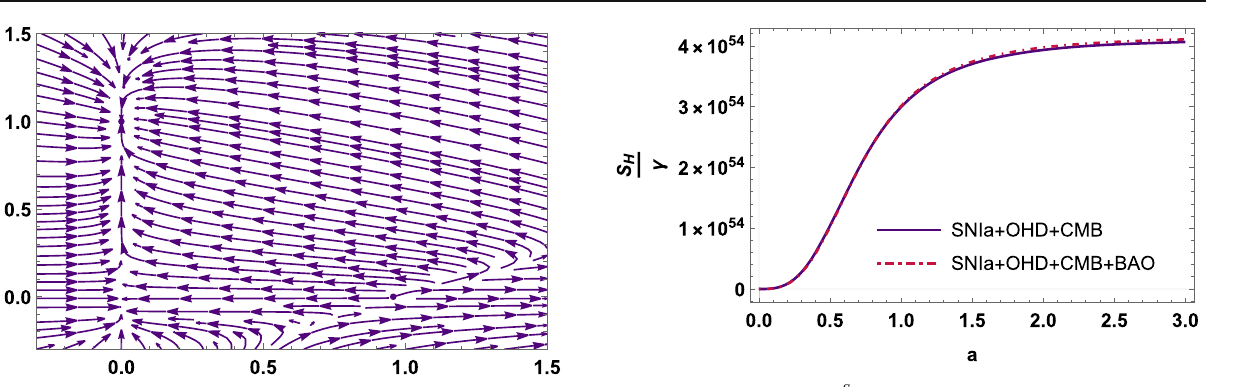
Fig. 10 The evolution of S H γ with scale factor for the best estimated values of the model parameters using the fourth and sixth datasets